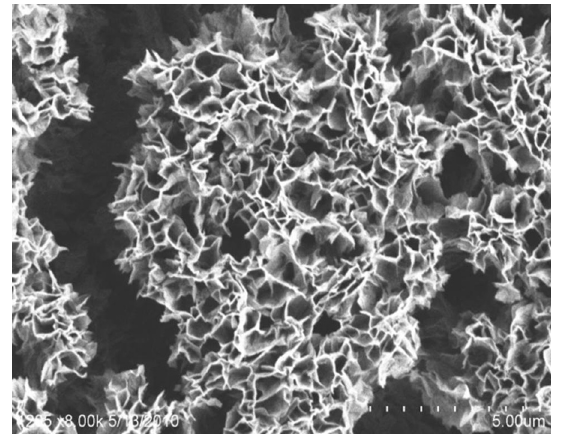
Figure 3. Representative SEM image of as-deposited cobalt hydroxide on AISI 304 stainless steel plate at ×8000